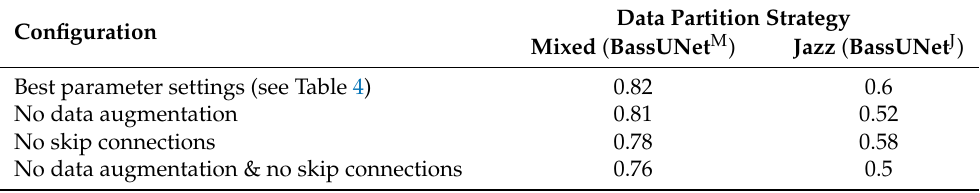
Table 5. Ablation study results. Overall accuracy (OA) values on the validation sets reported for the optimal configuration (first row) and training configurations derived by removing data augmentation and skip connections separately and jointly from the model training (remaining